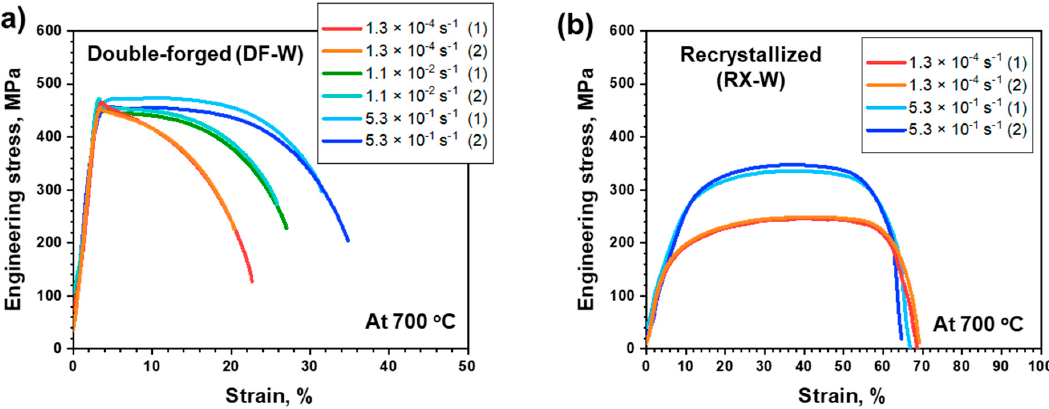
Figure 2. The stress–strain curves of W under various stain rate conditions: ( a ) DF-W and ( b ) RX-W.